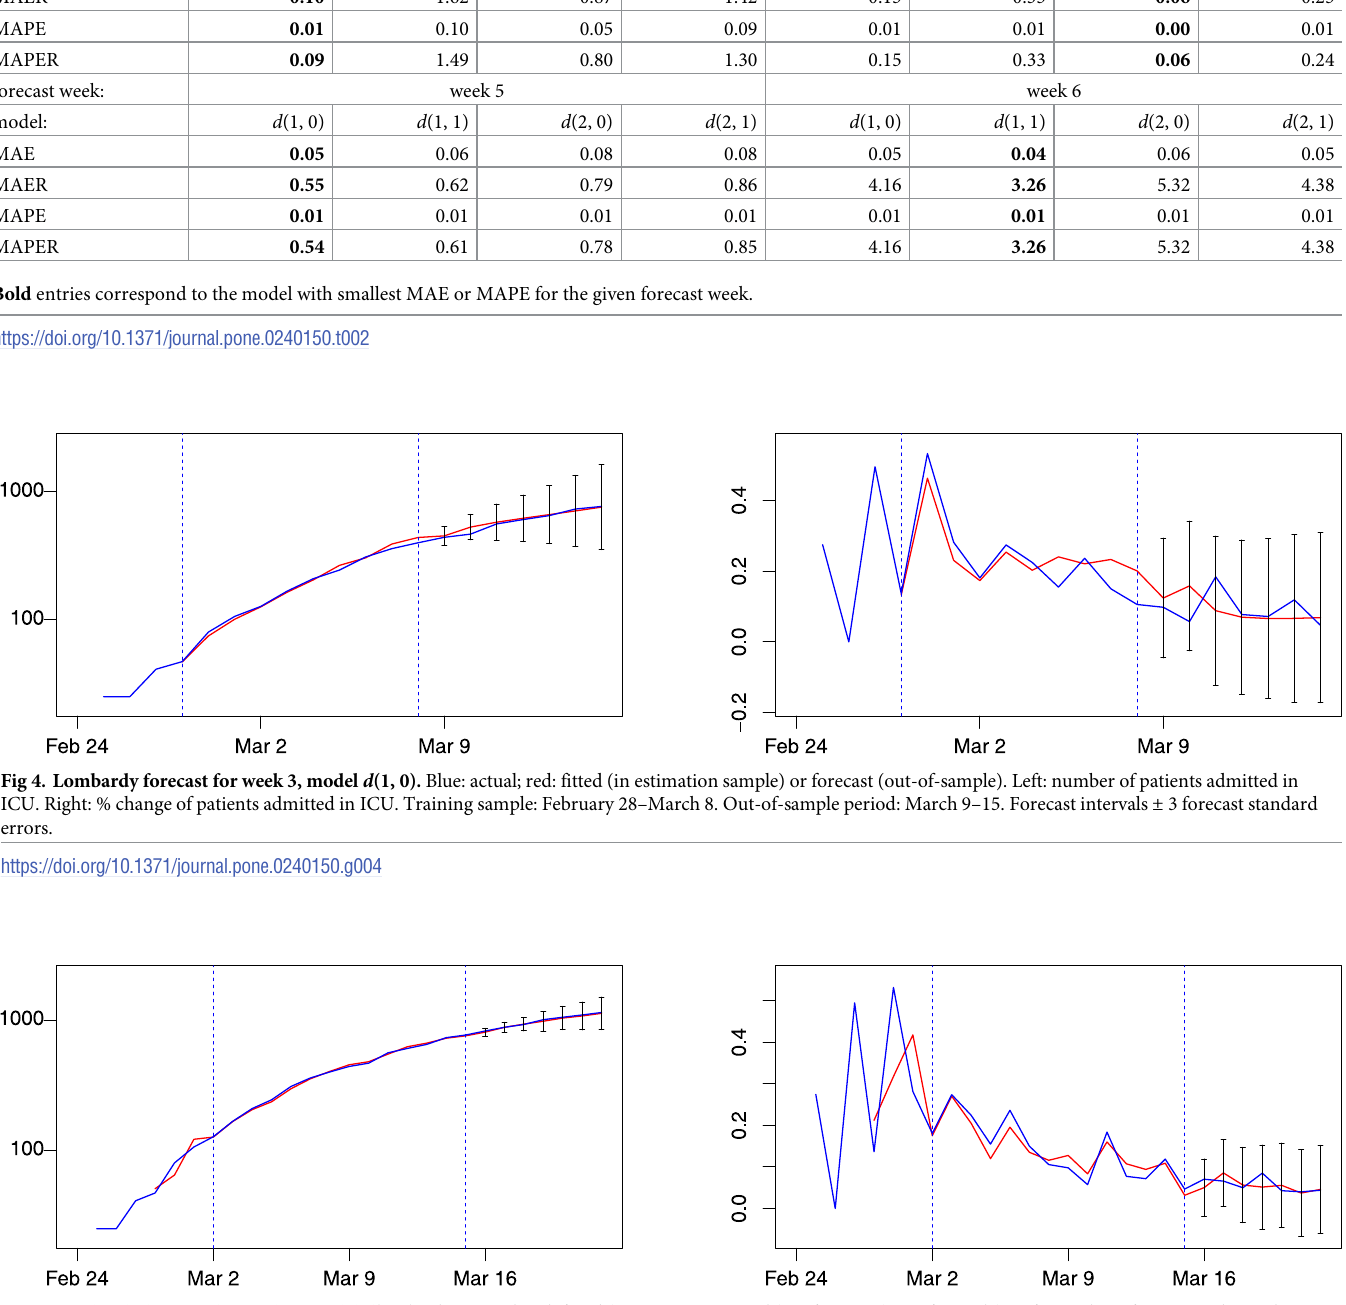
Fig 5. Lombardy forecast for week 4, model d (2, 0). Blue: actual; red: fitted (in estimation sample) or forecast (out-of-sample). Left: number of patients admitted in ICU. Right: % change of patients admitted in ICU. Training sample: February 28–March 15. Out-of-sample period: March 16–21. Forecast intervals ± 3 forecast standard